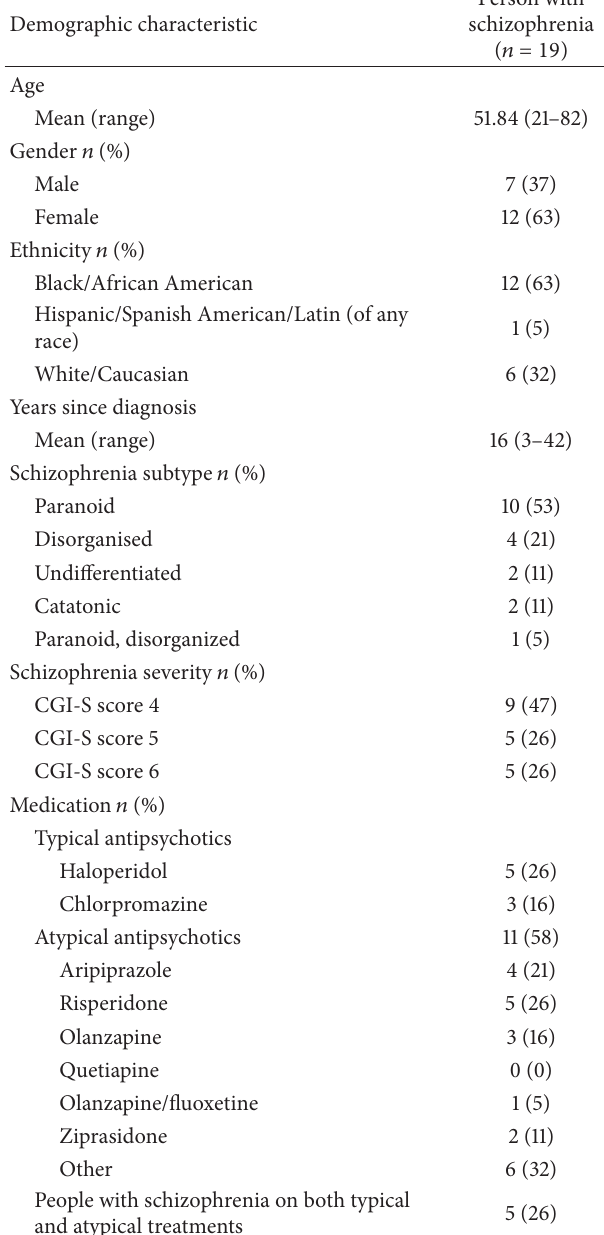
Table 1: Persons with schizophrenia and demographic and clinical characteristics (𝑛 = 19)